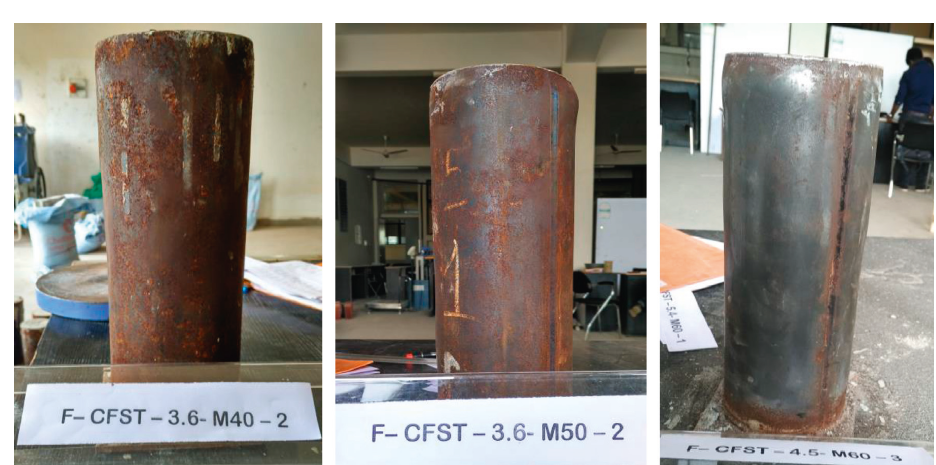
Figure 1: Failure shape of CFST-31.83-40, CFST-31.83-50, and